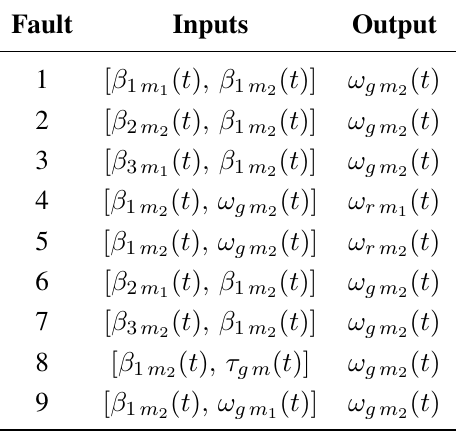
Table 5. Inputs and outputs for the fuzzy residual generator design.